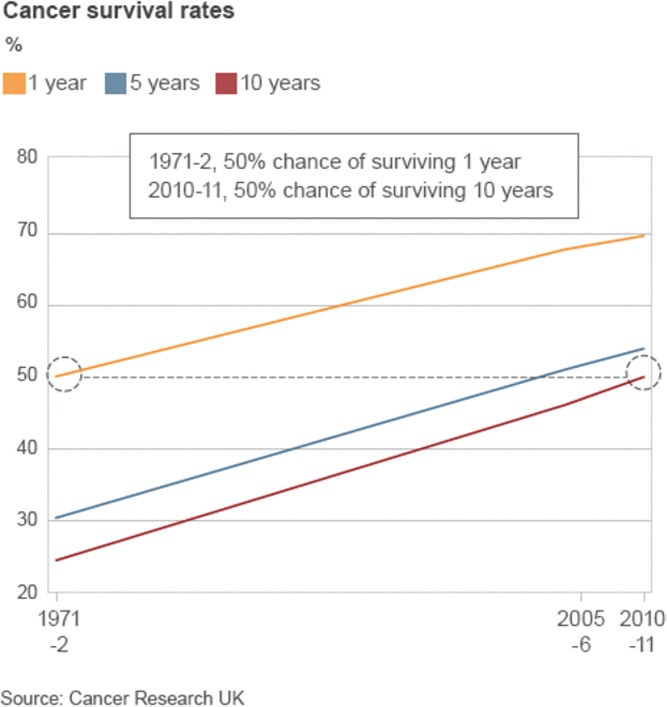
There has been a steady increase in the survival of cancer patients at one year, five years and at ten years between 1971 and 2010/11. Impressive and continuing increases in survival at one year and at five years are apparent. In particular, the survival of cancer patients in the UK ten years after their diagnosis, which will equate to cure for most of them, has increased from 25% in 1971 to over 50% in 2010/11.